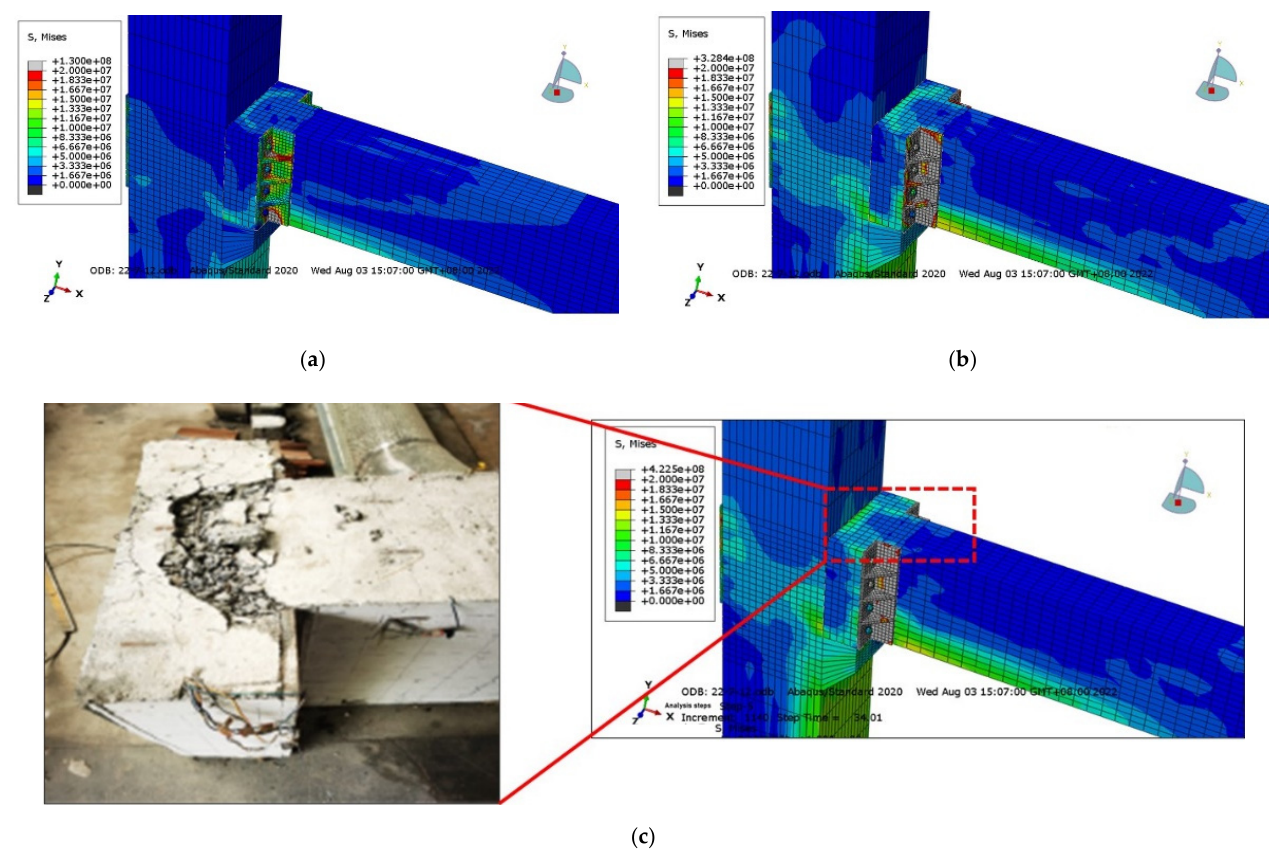
Figure 25. Stress cloud of specimen J1: ( a ) +20 mm stage stress cloud; ( b ) +50 mm stage stress cloud; ( c ) +70 mm stage stress cloud.